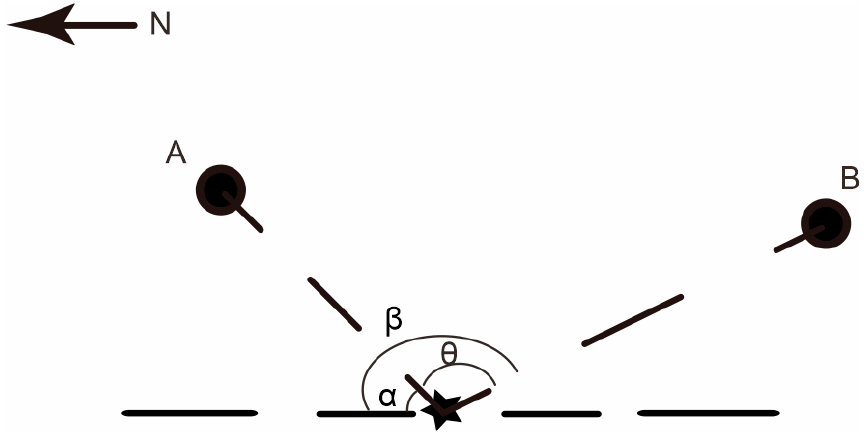
Figure 3. Determination of the deviation angle.